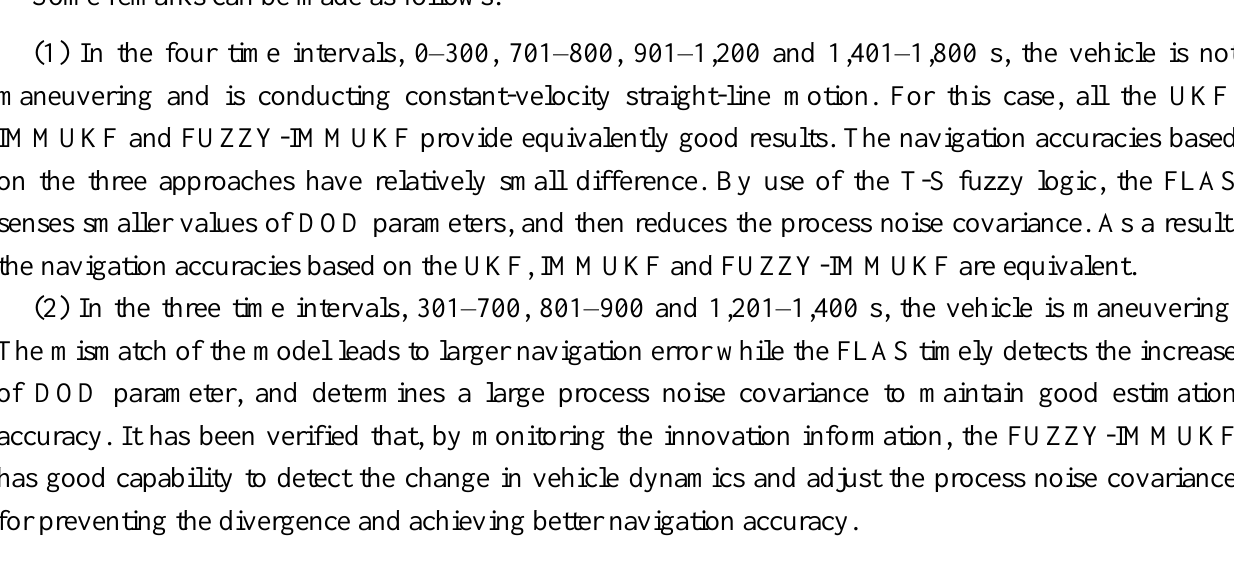
Figure 10. Comparison of the navigation accuracy for UKF and IMMUKF.